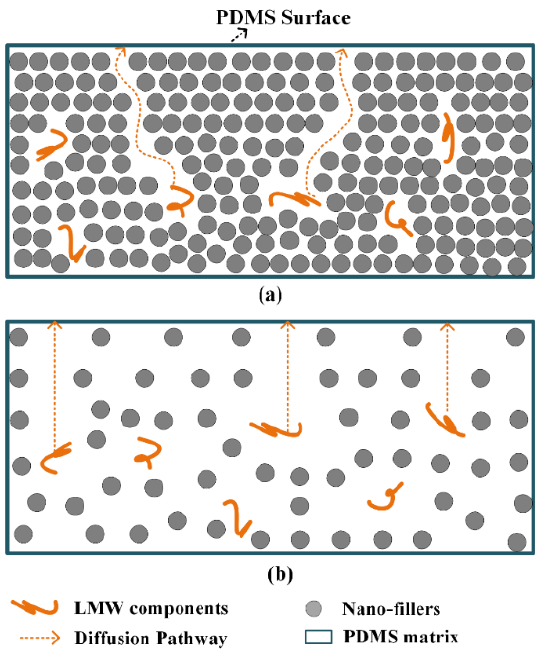
Figure 6. Schematic of LMW diffusion in silicone rubber with ( a ) high filler contents ( b ) low filler contents.